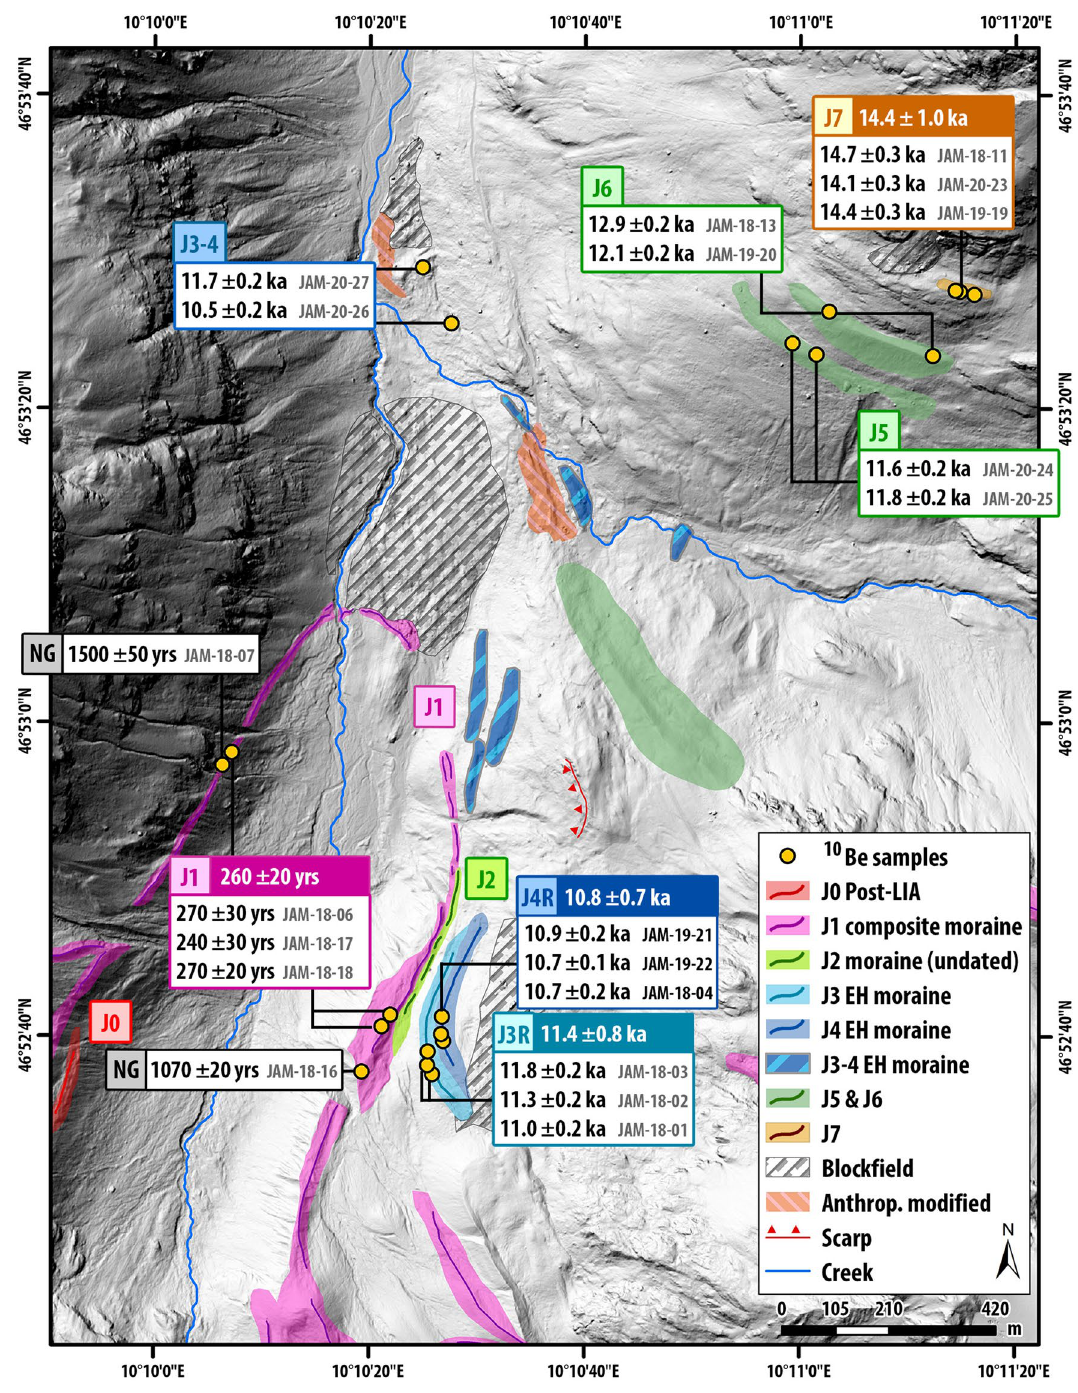
Figure 5. Late Glacial and Holocene moraine chronology of Jamtal. Boulder ages depicted in the lower half of the map (i.e., Holocene ages except samples JAM-20-26 and JAM-20-27) are published in Braumann, et al. 9 New ages presented in this study (top half of the map) complement the Holocene time scale and indicate ice margin positions during the Oldest Dryas–Bølling transition (J7 in brown) and during the YD (J5 and J6 in green). DEM provided by Land Tirol—www. tirol. gv. at/ als, CC BY 4.0. The map was created using ArcGIS